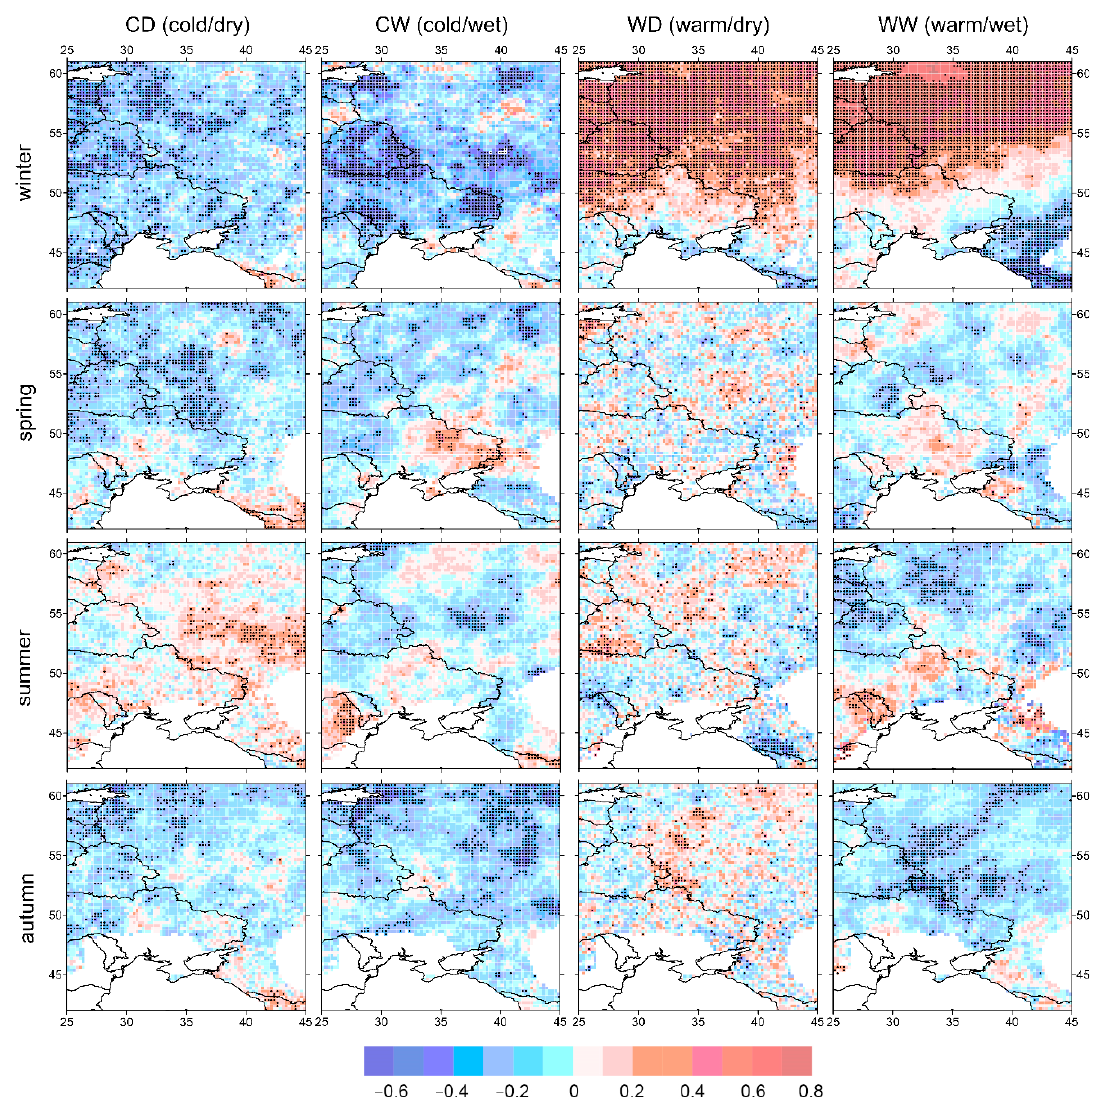
Figure 5. The spatial distribution of correlation coefficients for compound extreme indices and the NAO. Statistically significant correlation coefficients ( p < 0.05) are shown as black dots.